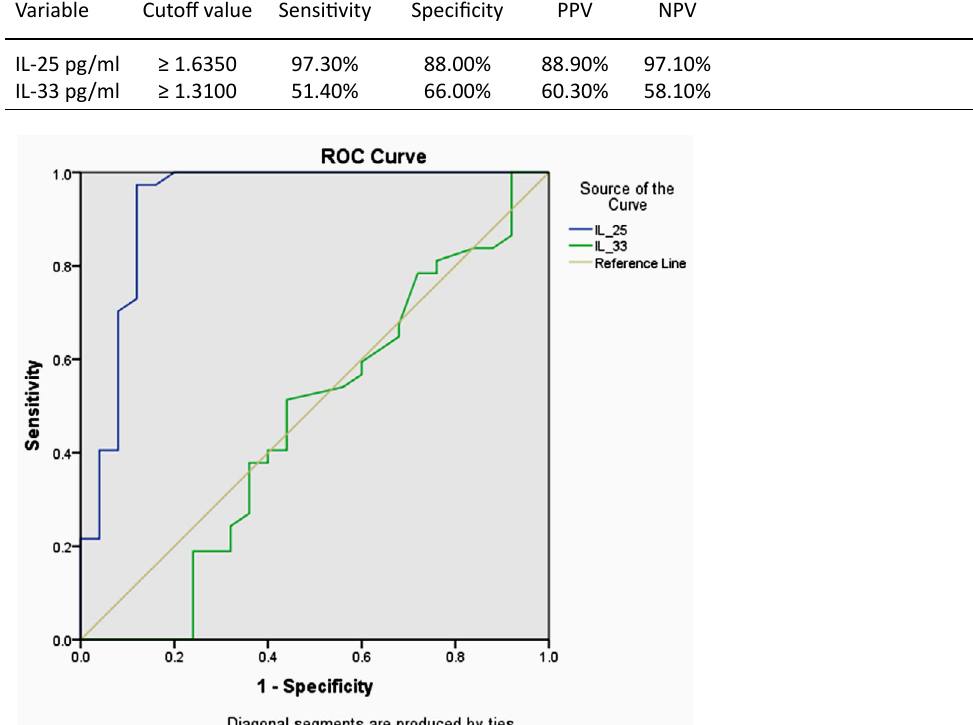
Table 2. Sensitivity, specificity, positive, and negative predictive value for IL-25, and IL-33. Variable